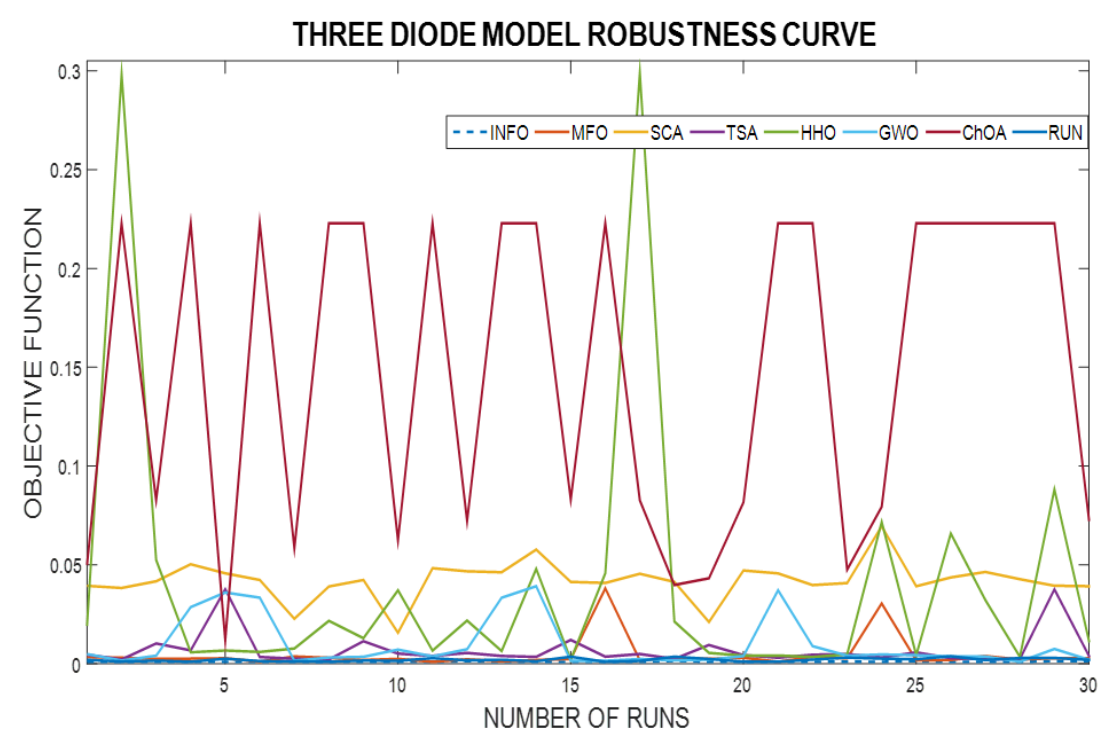
Figure 15. Robustness curve for the TDMSC.